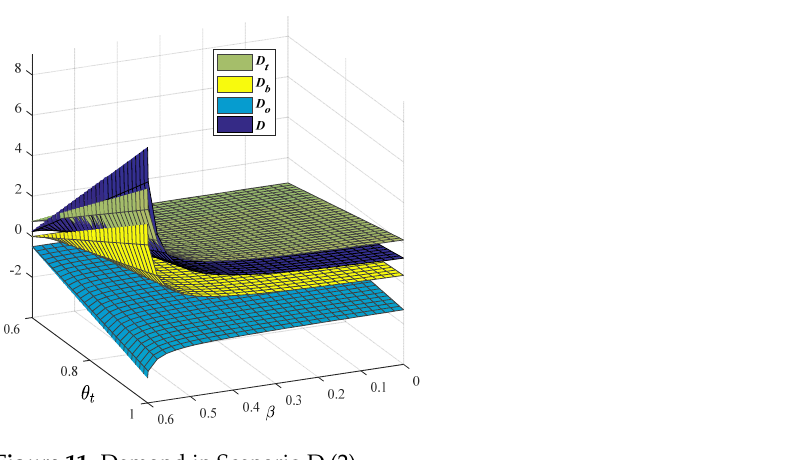
Figure 11. Demand in Scenario D (2).